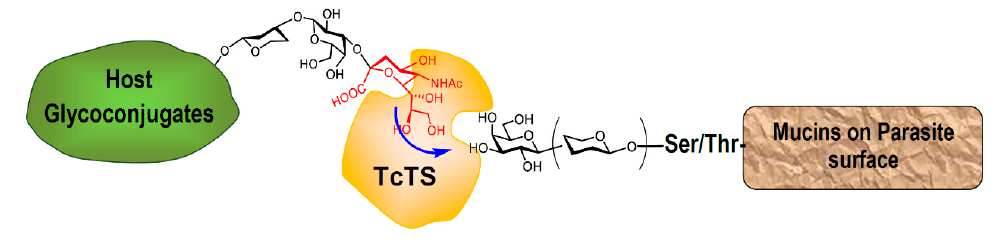
Figure 3. Trans-sialidase from T. cruzi transfers sialic acid from host sialoglycoconjugates to β -Gal p - containing glycoproteins expressed on the parasite’s surface.